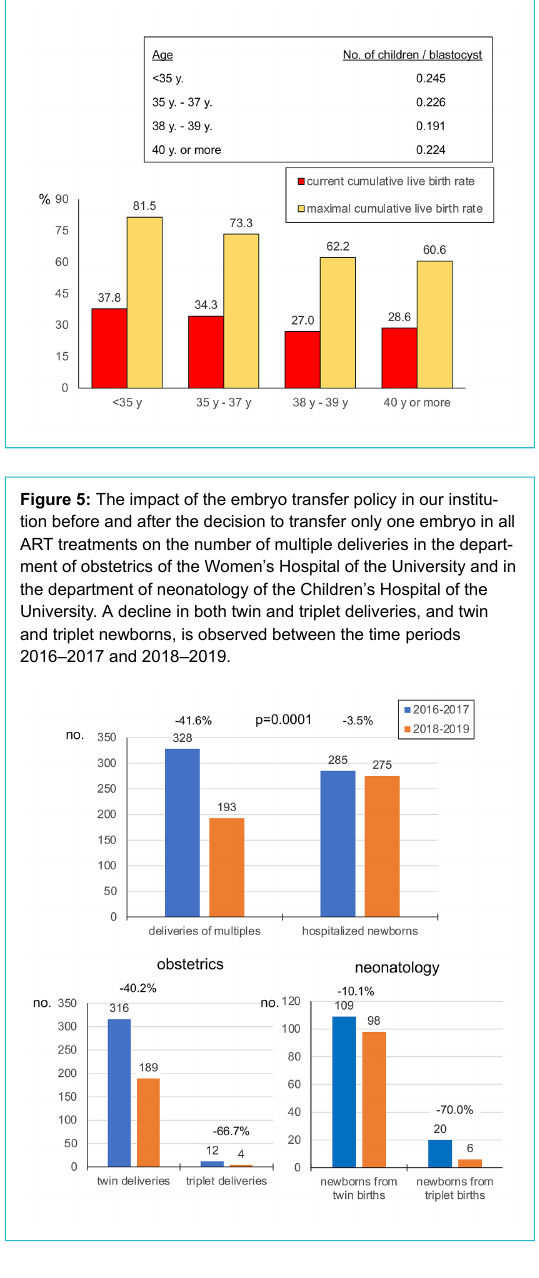
Figure 4: The number of children per transferred blastocyst was calculated for different age groups and was multiplied by the total number of blastocysts per infertile couple still remaining cryopre- served (inset table). The cumulative live birth rate per oocyte col- lection achieved during the observation period is compared with the maximum cumulative live birth rate calculated from the total number of blastocysts originating from the oocyte collections per- formed in 2018 and 2019.